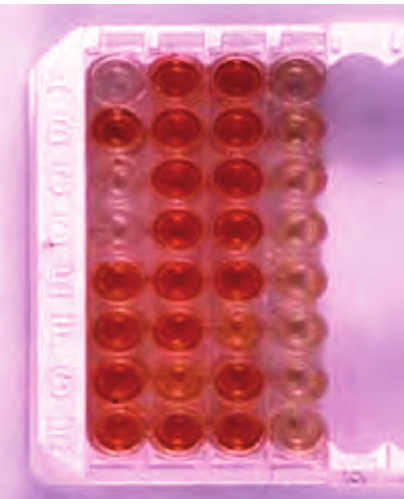
Figure 2: Diagnosis of rabies by the Rapid Rabies Enzyme Immun- odiagnosis (RREID) technique. Note the dark brown colouration obtainedwithrabiespositivebrainsincomparisontonegativebrains which appear